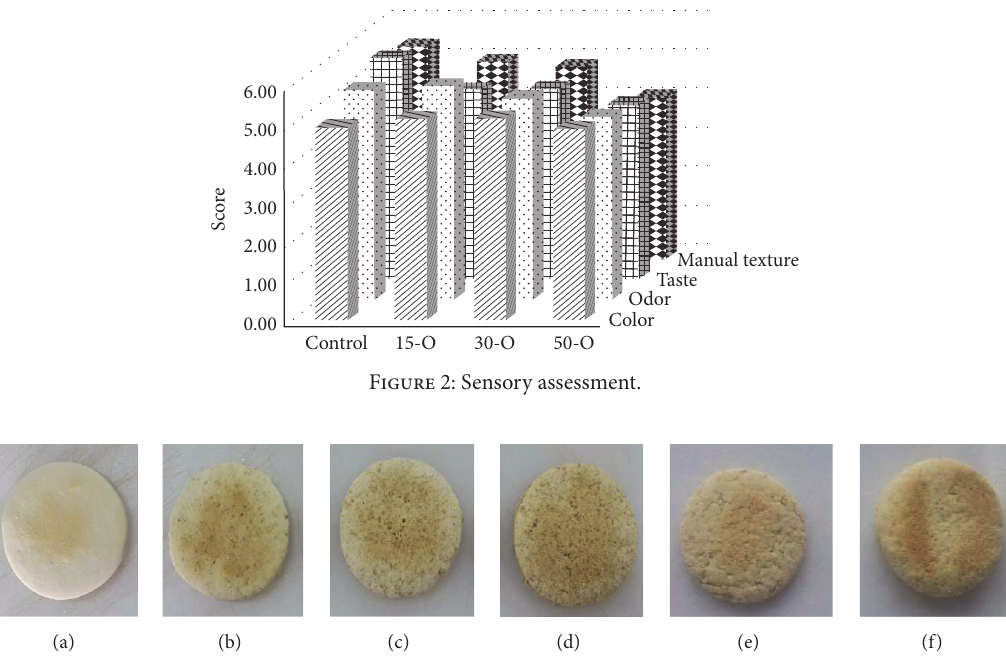
Figure 3: Photographs of cookies with different okara levels. (a) Control; (b) 15-O; (c) 30-O; (d) 50-O; and (e)